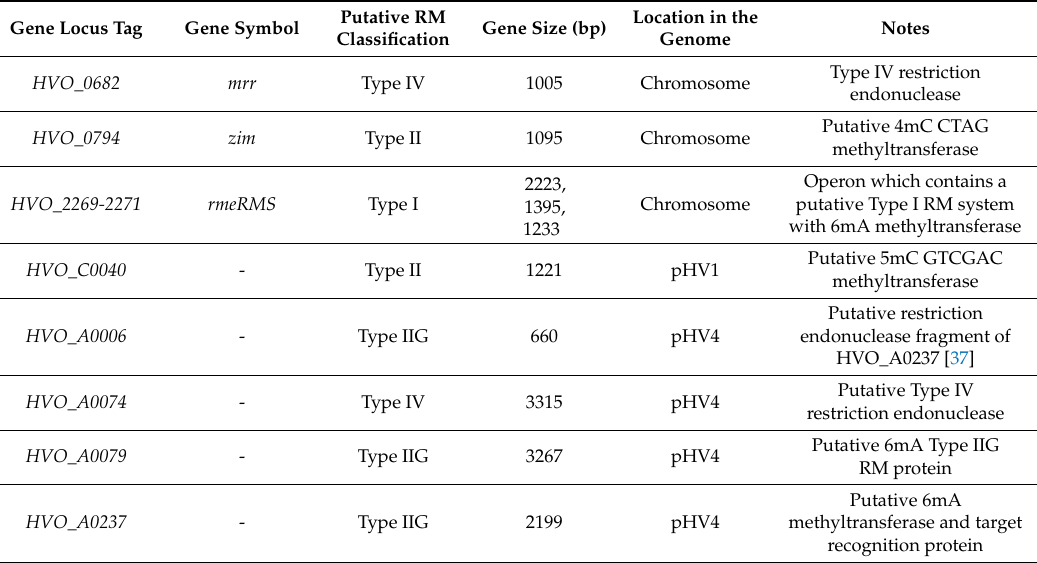
Table 2. List of restriction-modification (RM) genes annotated in Haloferax volcanii DS2.